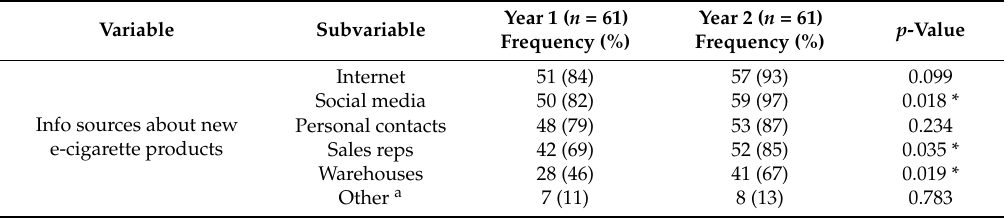
Table 3. Informational sources and deciding factors influencing marketed vape shop items ( n = 61) using simple logistic